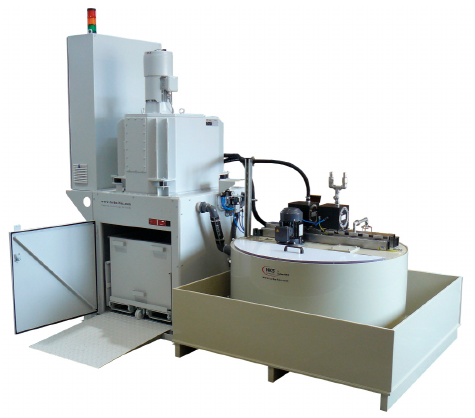
Figure 3. The centrifugal cleaning system which separates process water from solid waste [17].